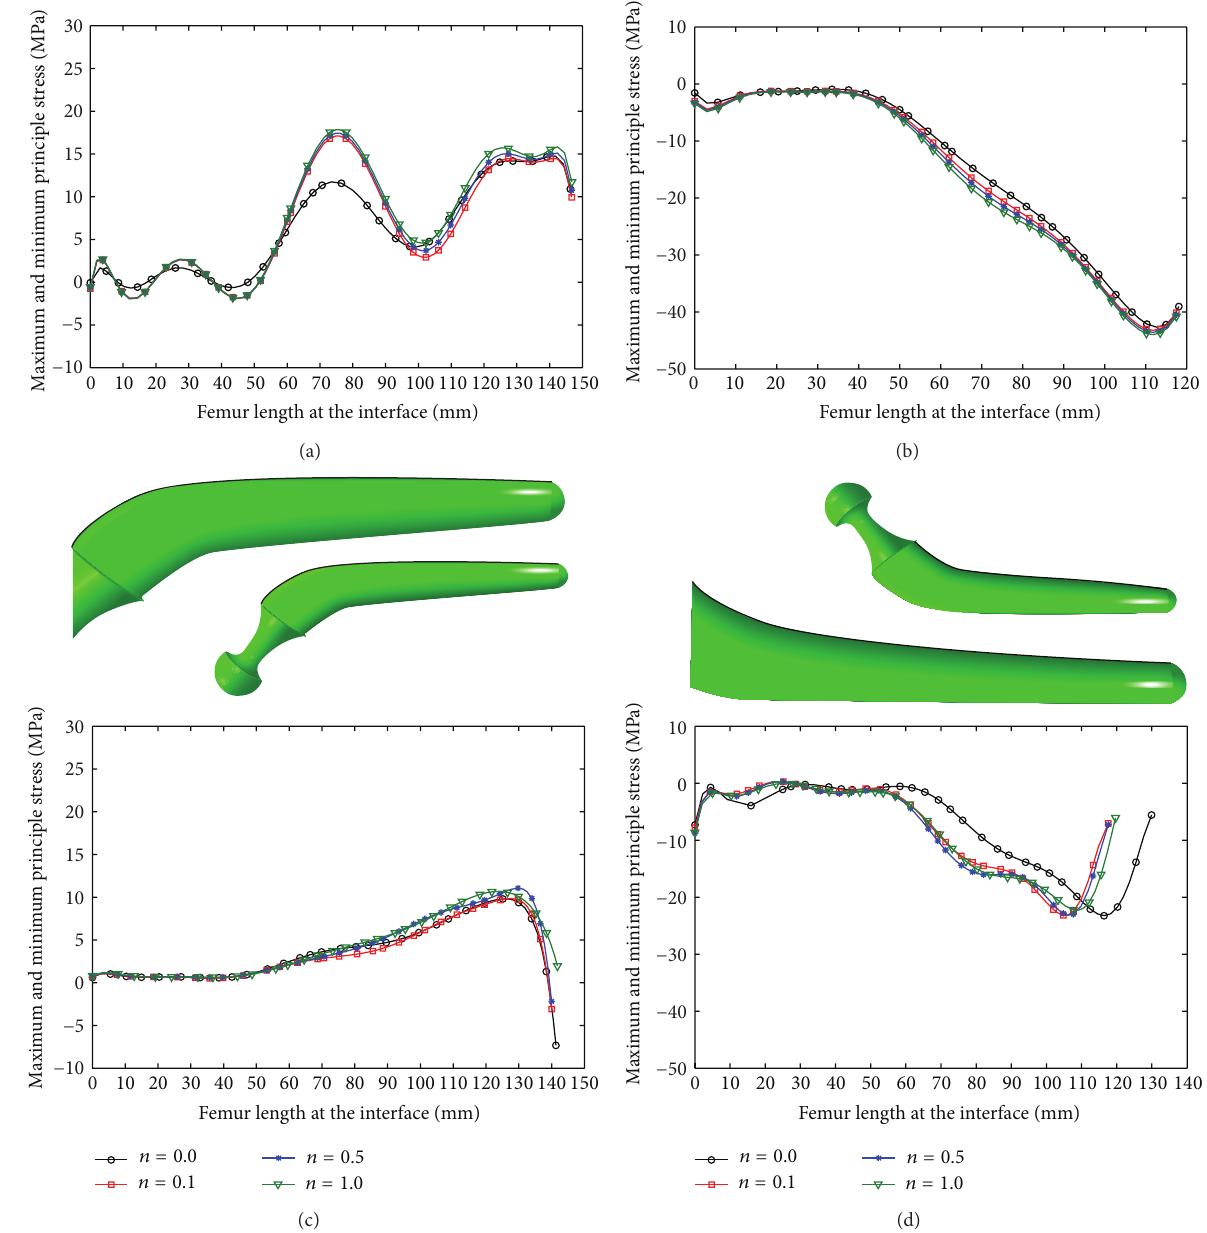
Figure 10: Stress variation on the internal surface of the femur under stair climbing: (a) maximum principal stress, cemented prosthesis, (b) minimum principal stress, cemented prosthesis, (c) maximum principal stress, noncemented prosthesis, and (d) minimum principal stress, noncemented